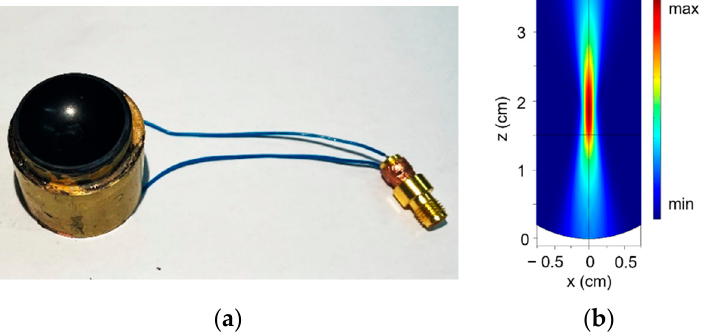
Figure 10. ( a ) Fabricated ultrasonic transducer with focal lens; ( b ) simulated acoustic field diagram of the focused transducer.